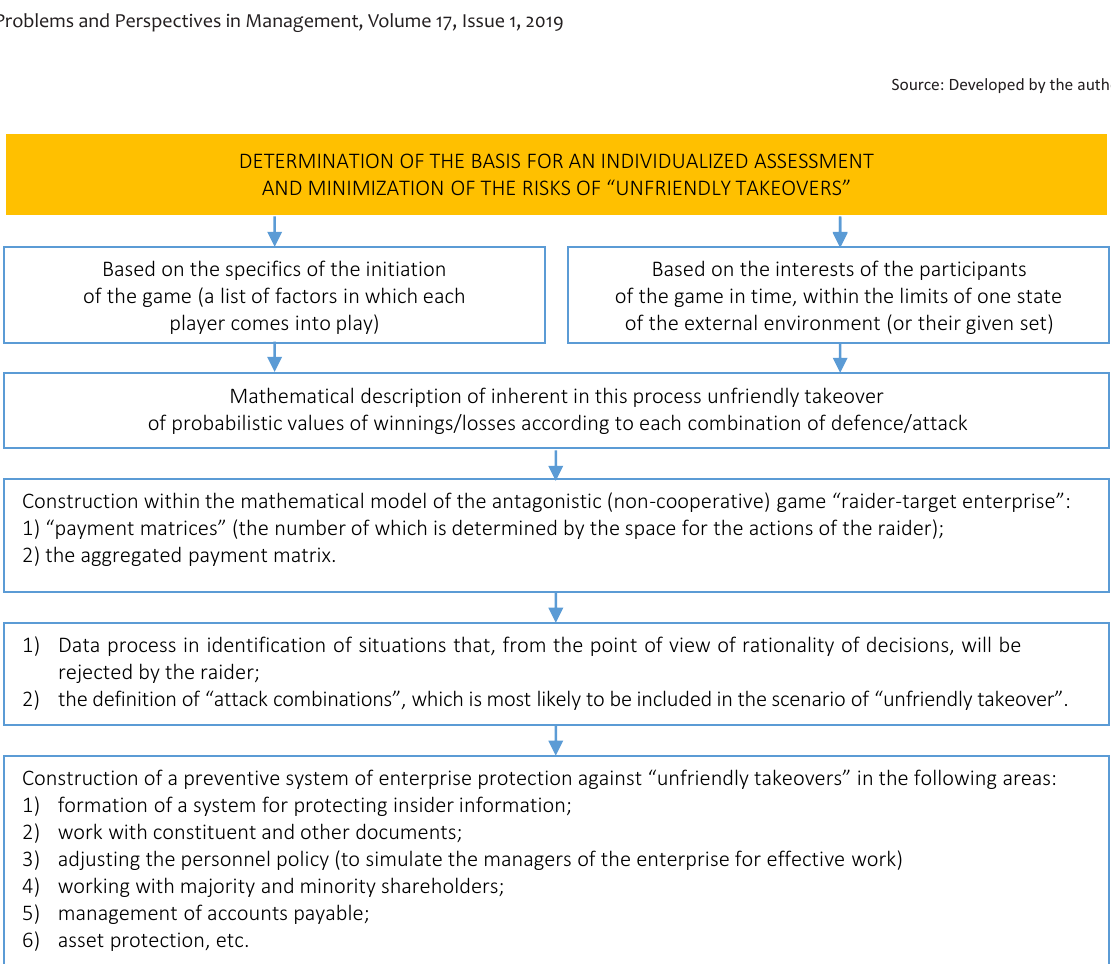
Figure 1. Algorithm of individualized estimation and